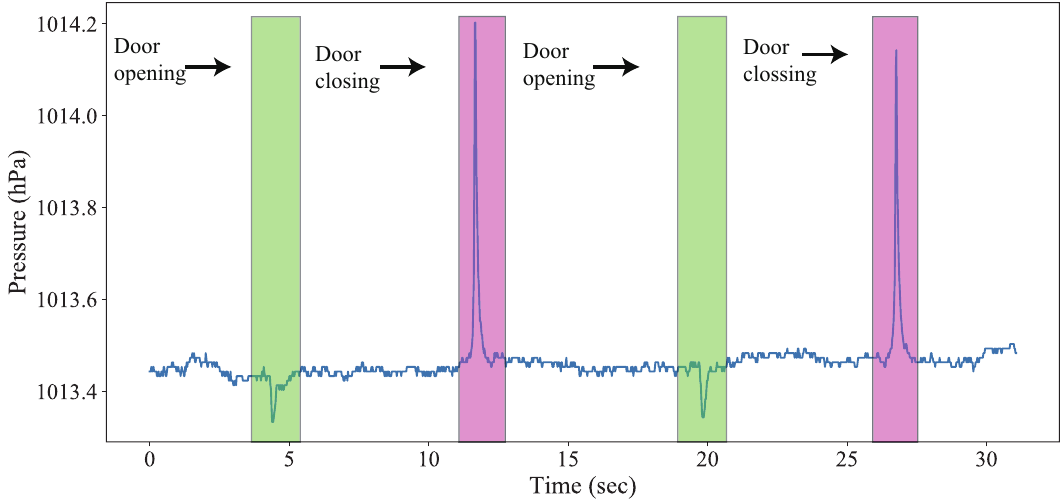
Figure 1. Atmospheric pressure variation due to the vehicle door opening/closing events.